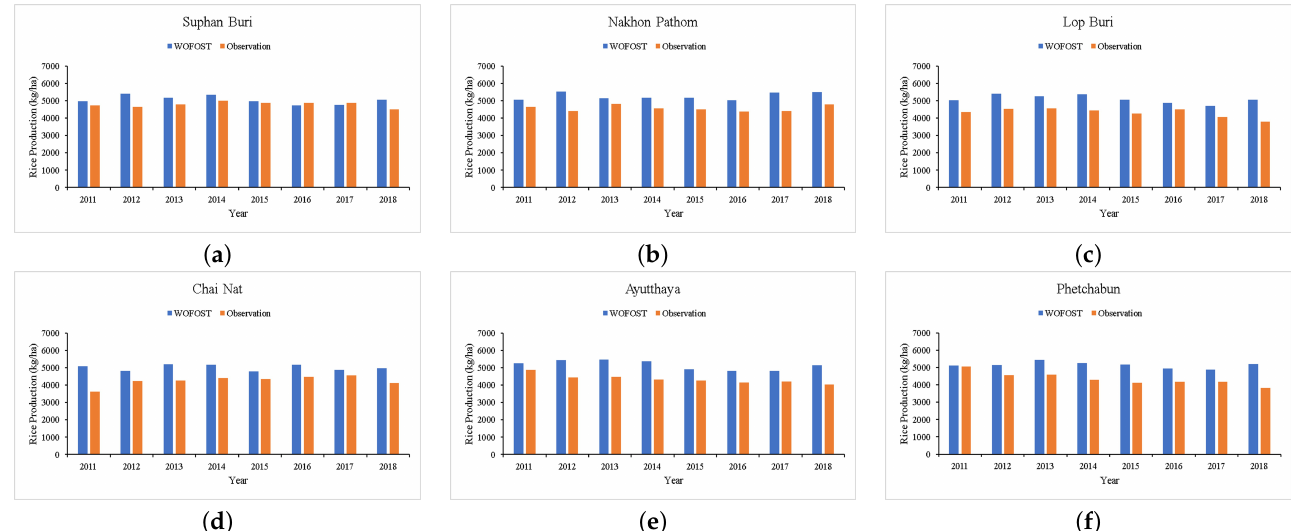
Figure 5. Comparison of rice yield between the WOFOST model and observed data. ( a ) Suphan Buri, ( b ) Nakhon Pathom,